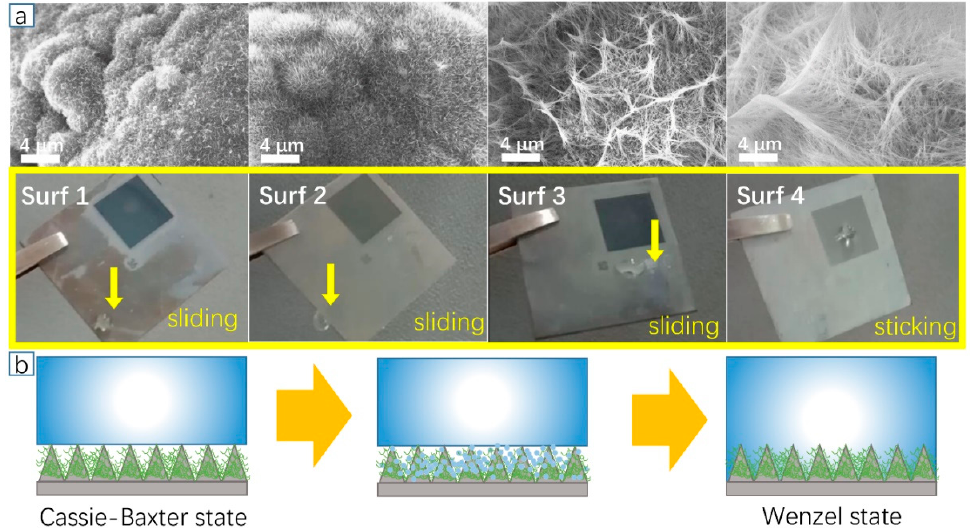
Figure 7 . ( a ) Water droplet adhesion test after 3 min at a temperature of − 5 °C; ( b ) The abridged general view of transformation from the Cassie–Baxter state to the Wenzel state by decreasing the ambient temperature.